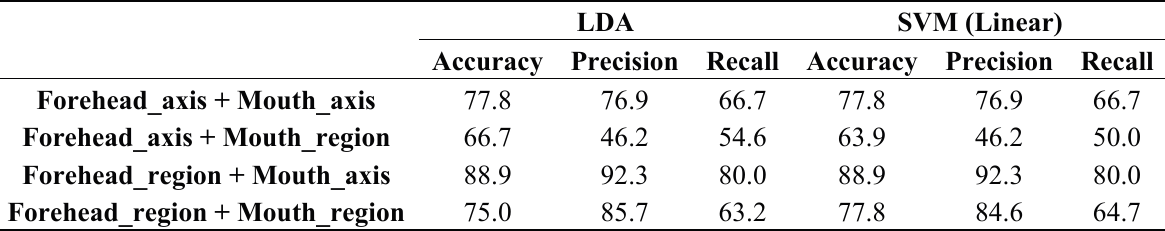
Figure 7. ( a ) 2D plot of asymmetry indices for forehead and mouth region for normal subjects and patients; ( b ) Bar graphs show mean values and standard deviation of asymmetry indices for forehead and mouth regions for normal subjects and patients. Table 1. Comparison of classification accuracy, precision and recall rate for LDA and SVM with linear kernel on combinations of asymmetry